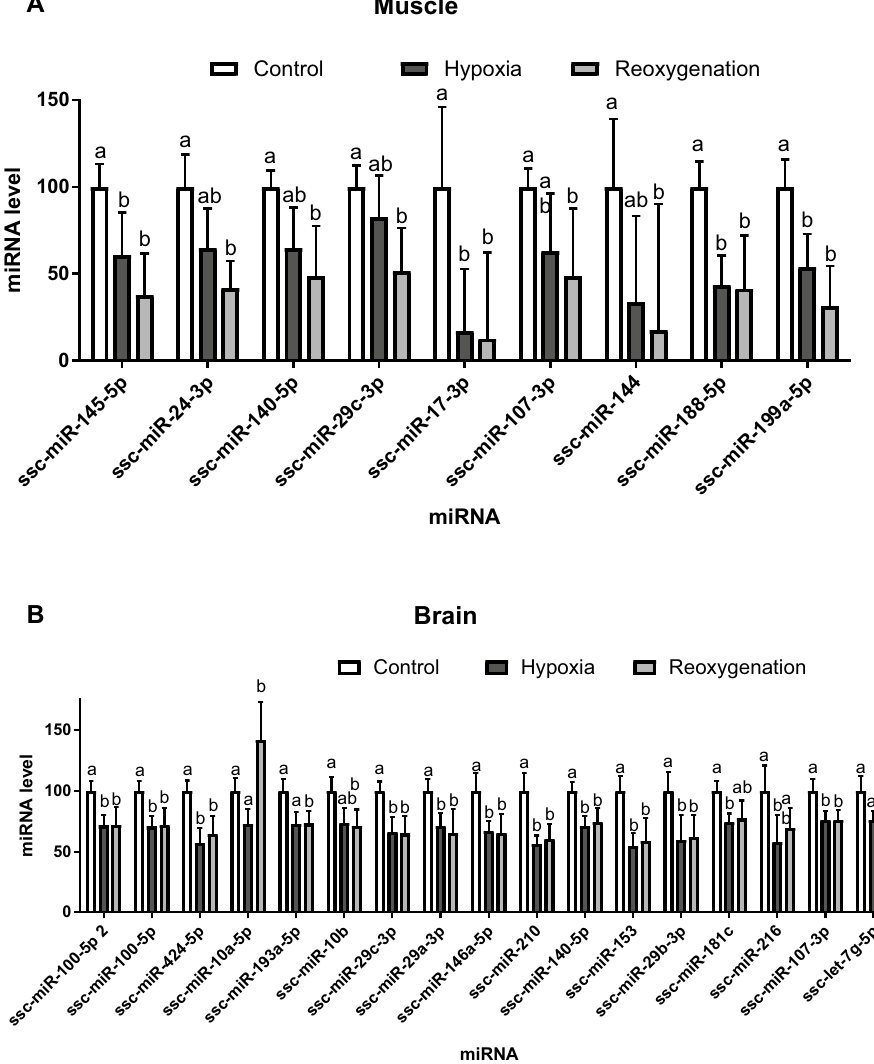
Figure 5. Effect of the H-R stress on miRNA expression in the isolated skeletal muscle and brain cells of S. scrofa. ( A ) skeletal muscle cells, ( B ) brain cells. Only the miRNAs that showed significant ( P <0.05) changes in expression in hypoxia and/or reoxygenation relative to the normoxic controls are shown. Letters indicate differences between the exposure conditions; columns that do not share a letter are significantly different ( P